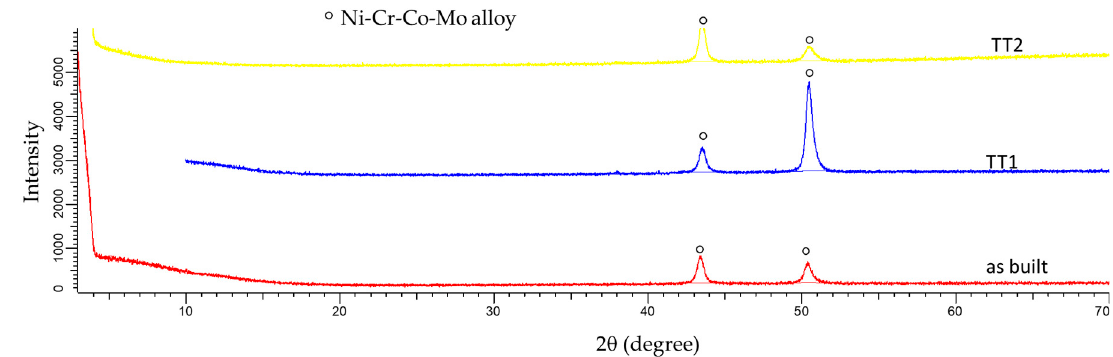
Figure 14. Pattern diffraction of specimens produced in argon conditions.